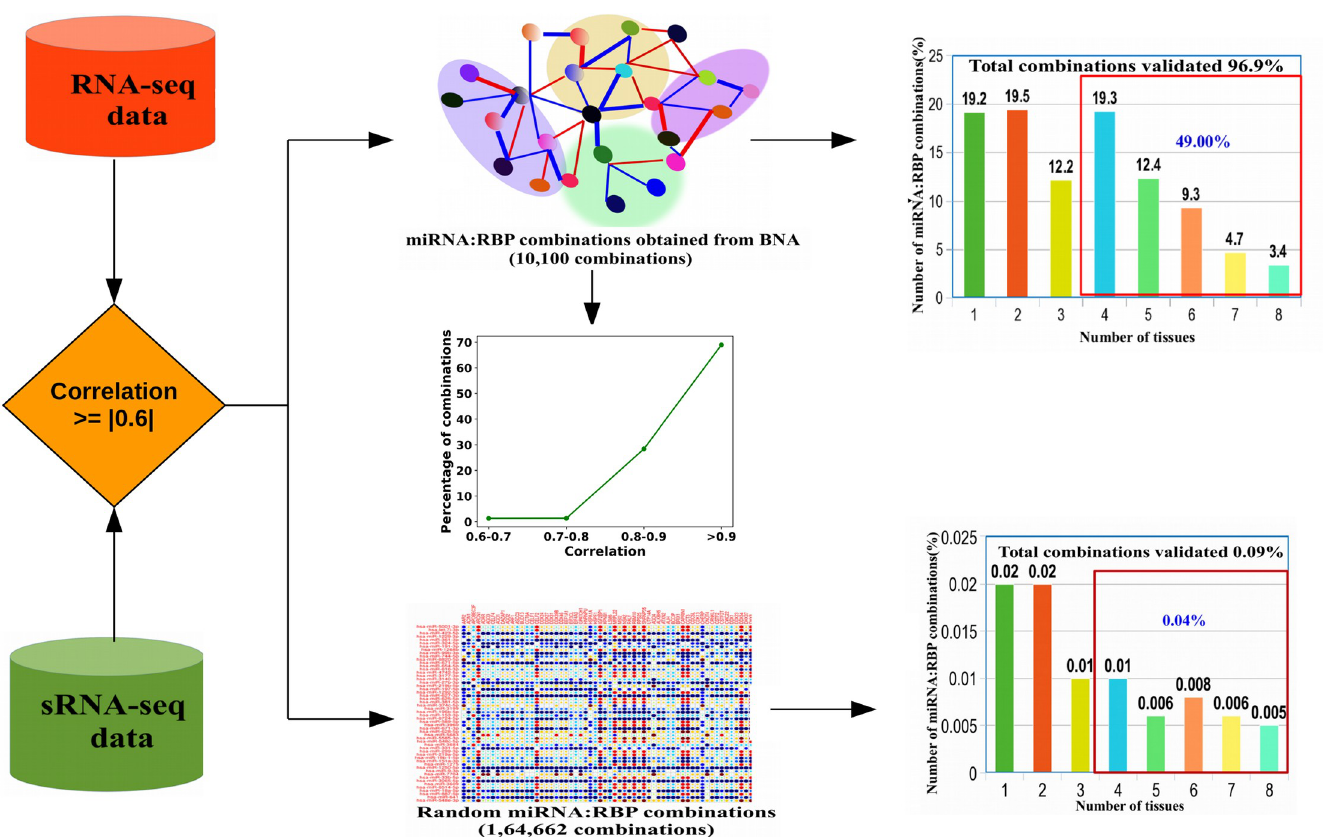
Fig 3. Validation of different miRNA:RBP combinations across totally different eight normal tissues (Bladder, Brain, Breast, Lungs, Pancreas, Placenta and Testis). The bar-chart shows the distribution of unique miRNA:RBP pairs across different tissues. A total of 96.9% miRNA:RBP combinations were validated across all the eight tissue which were never considered before while dealing with data or reconstructing the networks. 49% of miRNA:RBP combinations existed in four or more tissue. Only 0.09% of random miRNA:RBP combinations were found in them whose just 0.04% combinations existed in four or more tissue. Fisher’s exact test between the distributions for combinations obtained from BNA and randomized combinations was found significant. Also, all one-to-one binomial tests were found significant (p << 0.05) between the BNA obtained and randomly obtained